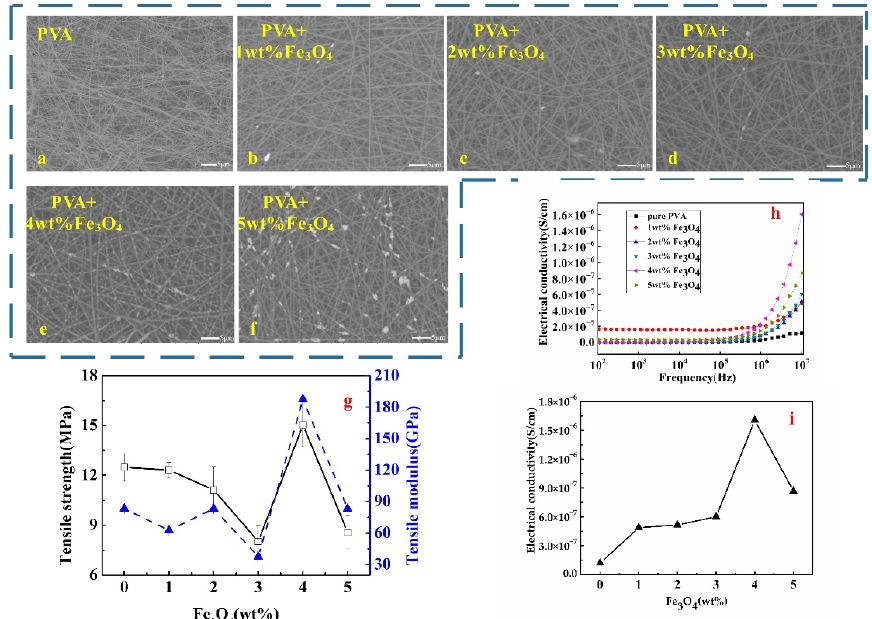
Figure 2. The performance of PVA/Fe 3 O 4 membrane in different mass fractions: ( a – f ) the surface of the membrane by SEM; ( g ) the tensile strength and modulus of membrane; ( h , i ) the conductive property of membrane in different frequencies.